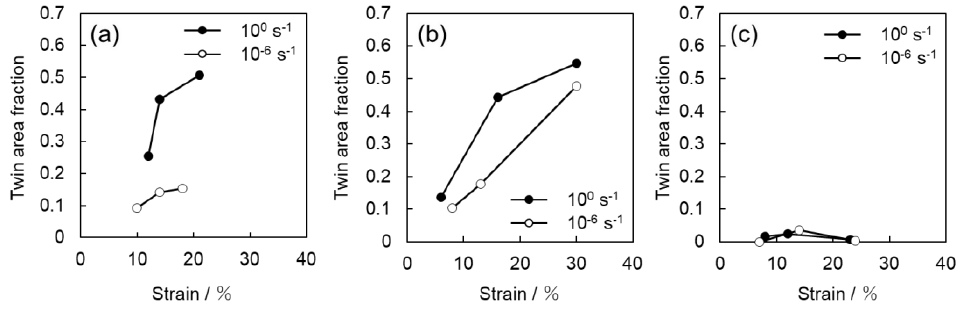
Figure 9. Strain dependence of the twin area fraction for ( a ) Ti-210, ( b ) Ti-30, and ( c ) Ti-5.